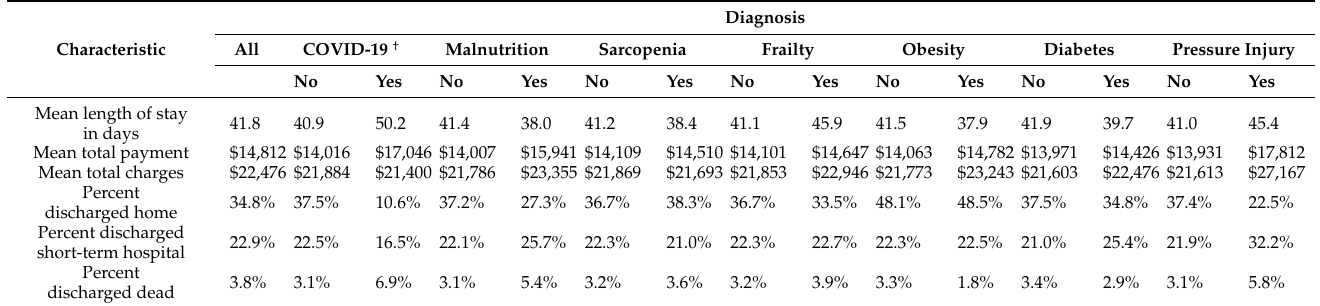
Table 3. Outcome characteristics for skilled nursing facility US Medicare claims for a set of specific diagnoses * (n =